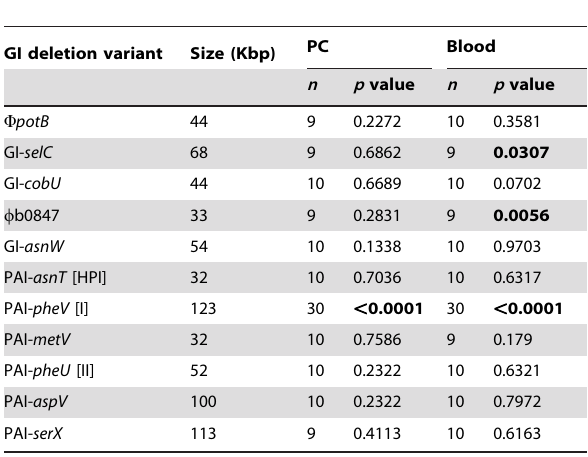
Table 1. Summary of GI screen in zebrafish infection